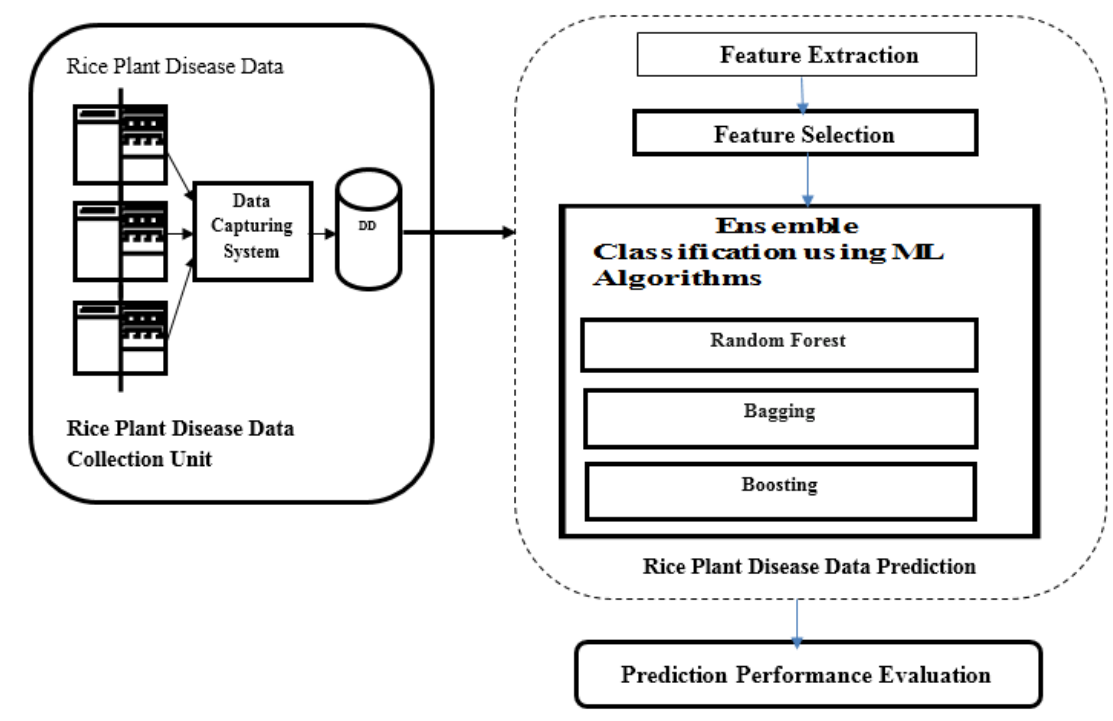
Figure 1. Proposed Overview of the Model.